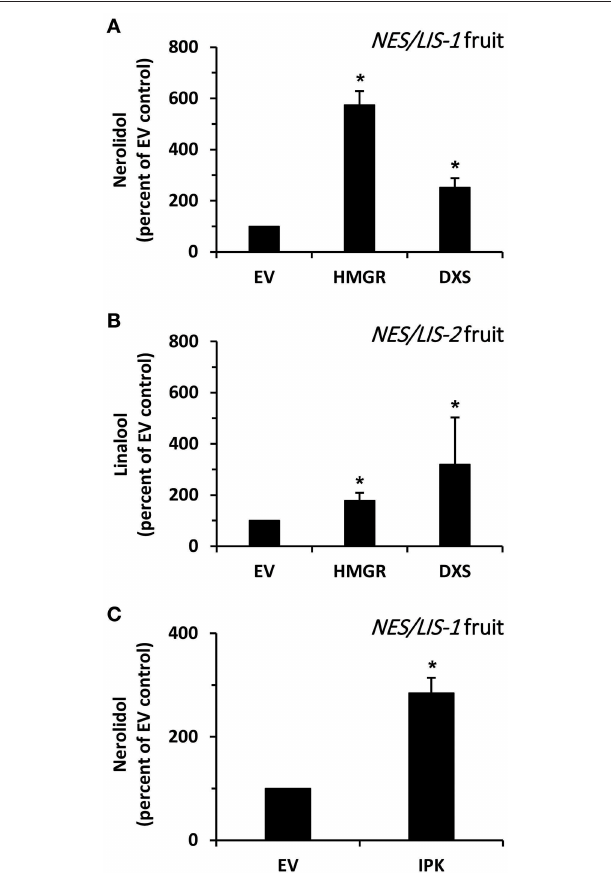
FIGURE 6 | The effect of HMGR, DXS, and IPK overexpression on nerolidol formation in AmNES/LIS-1 fruits. (A) Quantitative changes in amounts of nerolidol emitted from AmNES/LIS-1 fruits (line C13) upon transient overexpression of AtHMGR (HMGR) and AtDXS (DXS). Nerolidol contents are presented as percentage of the nerolidol content in AmNES/LIS-1 fruits injected with Agrobacterium carrying the empty pB2GW7 vector (EV), set as 100%. (B) Quantitative changes in amounts of linalool emitted from AmNES/LIS-2 fruits (line U8) upon transient overexpression of AtHMGR (HMGR) and AtDXS (DXS). Linalool contents are presented as percentage of the linalool content in AmNES/LIS-2 fruits injected with Agrobacterium carrying the empty pB2GW7 vector (EV), set as 100%. (C) Quantitative changes in amounts of nerolidol emitted from AmNES/LIS-1 fruits upon transient overexpression of AtIPK (IPK). The nerolidol content is presented as percentage of the nerolidol content in AmNES/LIS-1 fruits injected with Agrobacterium carrying the empty pB2GW7 vector (EV), set as 100%. Data are means ± SEM ( n ≥ 3). * P < 0.05 AmNES/LIS-1/-2 lines relative to the EV controls by Student’s t